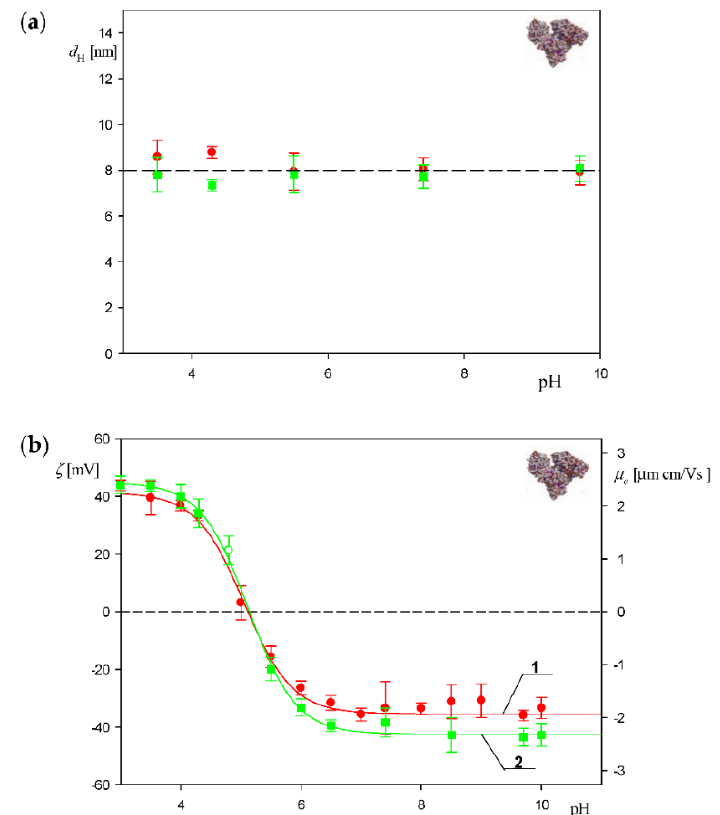
Figure 1. ( a ) Dependence of the hydrodynamic diameter of the HSA molecule on pH derived from the DLS measurements: ( (cid:4) ) 1 mM NaCl, ( • ) 10 mM NaCl. The line shows the average value of the hydrodynamic diameter equal to 8.0. ( b ) Dependence of the zeta potential of the HSA molecules (left-hand axis) and the electrophoretic mobility (right-hand axis) on pH derived from the LDV measurements: 1. ( • ) 10 mM NaCl, 2. ( (cid:4) ) 1 mM NaCl. The lines represent the guide for the